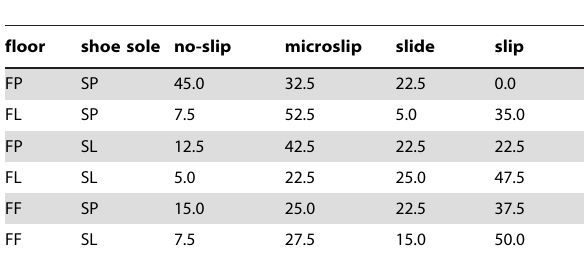
Table 3. Outcomes of the trials